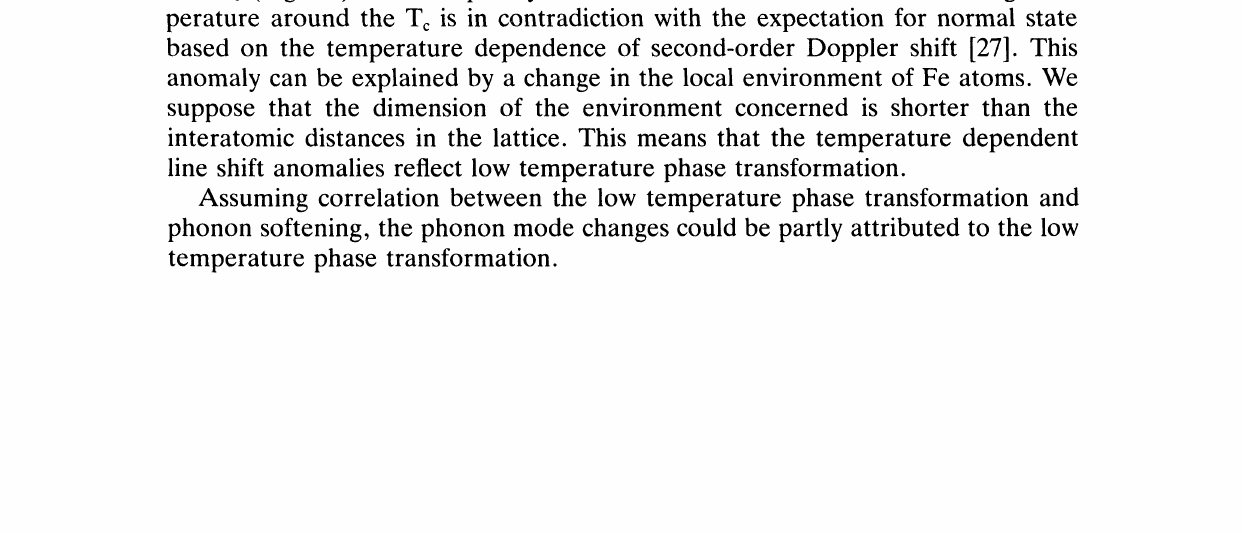
T (K) the total area fraction of 57Fe spectrum of FIGURE 9 Temperature dependence of